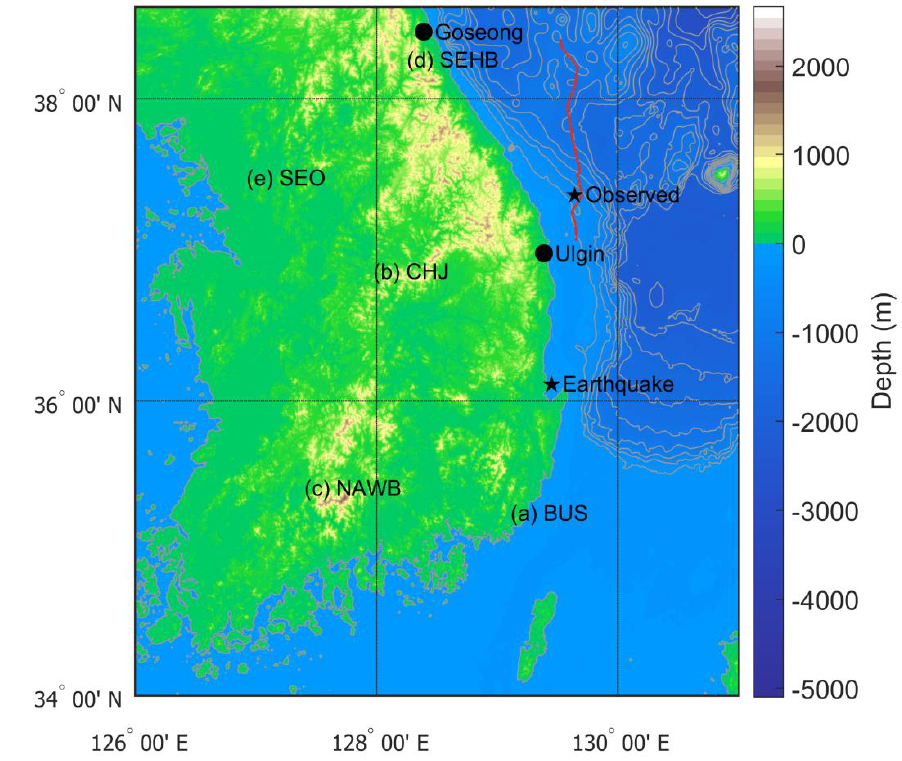
Figure 7. Underwater glider survey track (red line) map (seismic station: ( a ) Busan (BUS), ( b ) Chungju (CHJ), ( c ) Namwon (NAWB), ( d ) Seawha (SEHB), ( e ) Seoul (SEO)).